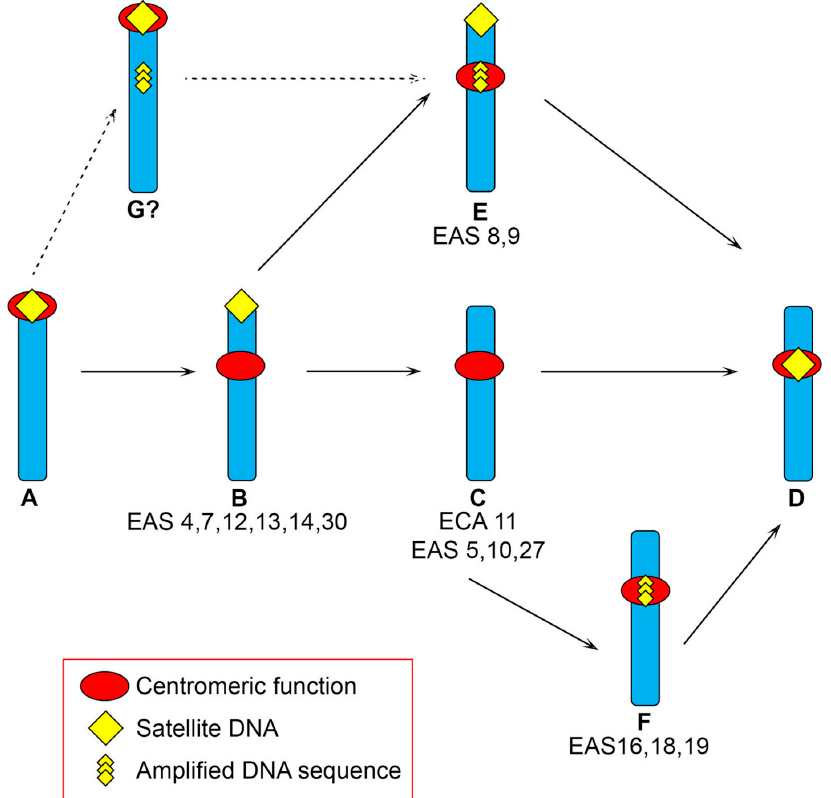
Figure 2. Model for the maturation of a centromere during evolution. Different routes are delineated leading to a mature satellite-based repositioned centromere ( D ) from an ancestral satellite-based centromere ( A ) through satellite-free intermediates ( B , C , E , F ). Route A–D: a neocentromere arises in a satellite-free region and satellite DNA remains at the ancestral position; the ancestral satellite DNA is lost from the non-centromeric terminus and, finally, the neocentromere acquire satellite repeats, giving rise to a “mature” neocentromere. This route follows the previously proposed model [14]. Routes A, B, E, D or A, B, C, F, D: at an already functional satellite-free neocentromere, amplification occurs as an intermediate step toward complete maturation of the neocentromere. Neocentromere maturation and loss of satellite DNA from the old centromere site are independent events that can occur at different stages. The 16 donkey chromosomes carrying a satellite-free neocentromere and the horse chromosome 11 exemplify satellite-free intermediates ( B , C , E , F ) and are listed below each step. It cannot be excluded that sequence amplification precedes neocentromere formation ( G ), but no chromosome corresponding to this step was found so far. Modified from [13,14] .